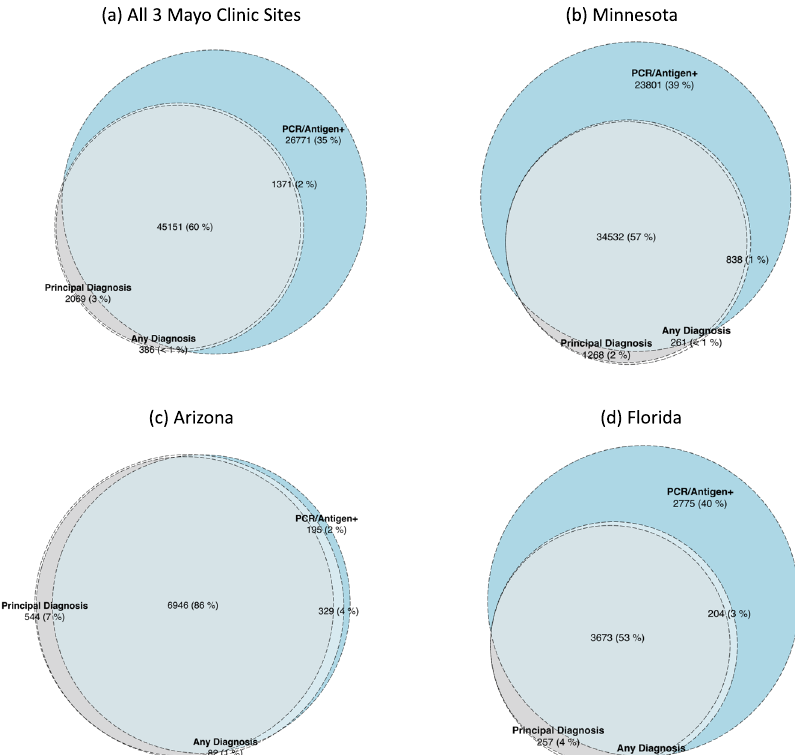
Fig. 4 SARS-CoV2 case counts by computational phenotyping strategies in the Mayo Clinic System. Computable phenotypes for SARS- CoV-2 infection across the study period at the Mayo Clinic System, a across all Mayo Clinic sites, b Rochester, c Arizona, and d